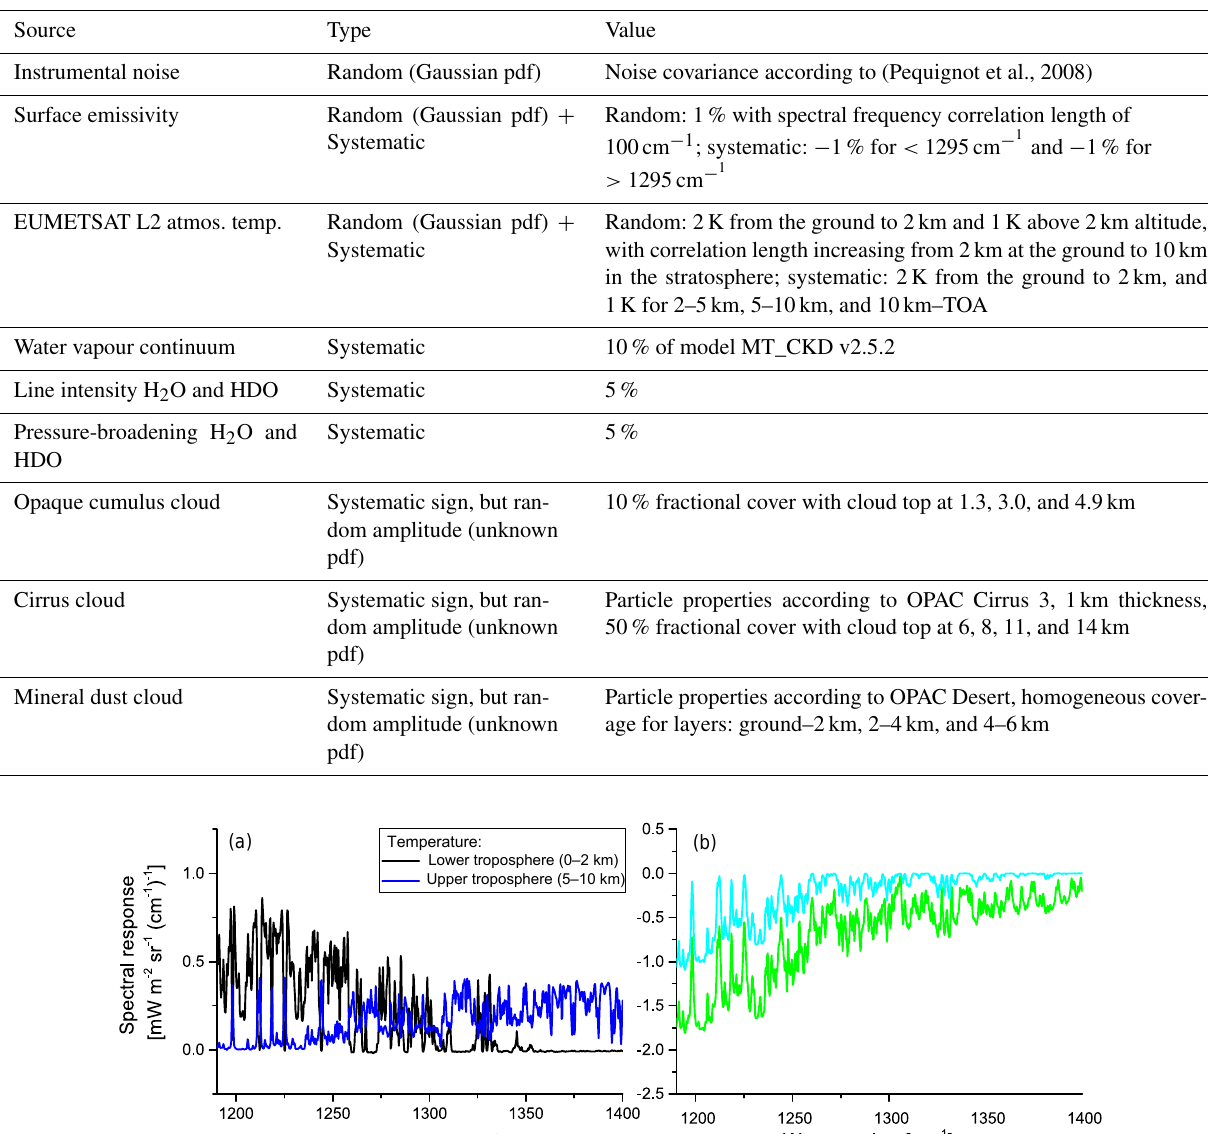
Table 2. List of uncertainty assumptions used for the error estimation of the MUSICA IASI water vapour product (for emissivity and atmospheric temperature, we assume random and systematic uncertainties). The abbreviation “pdf” refers to the probability distribution function.